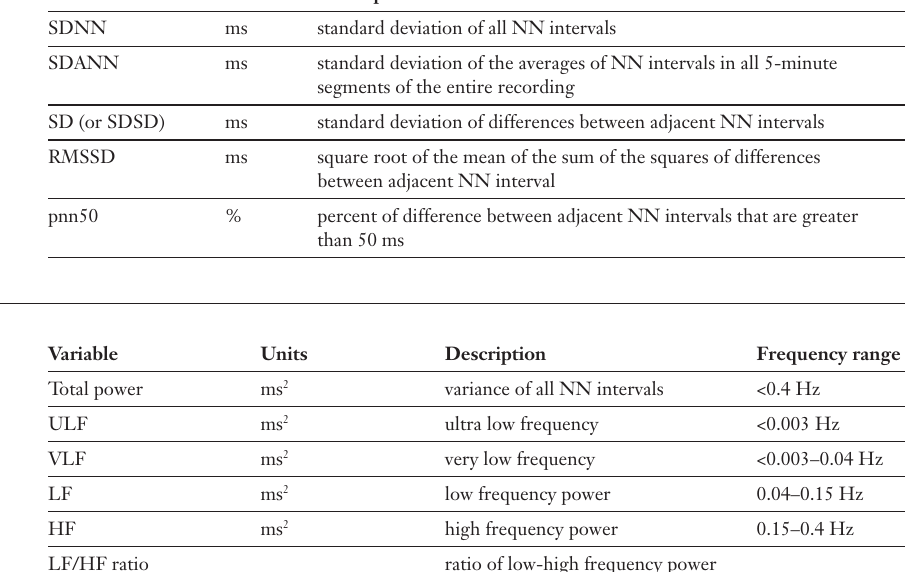
Time domain parameters.